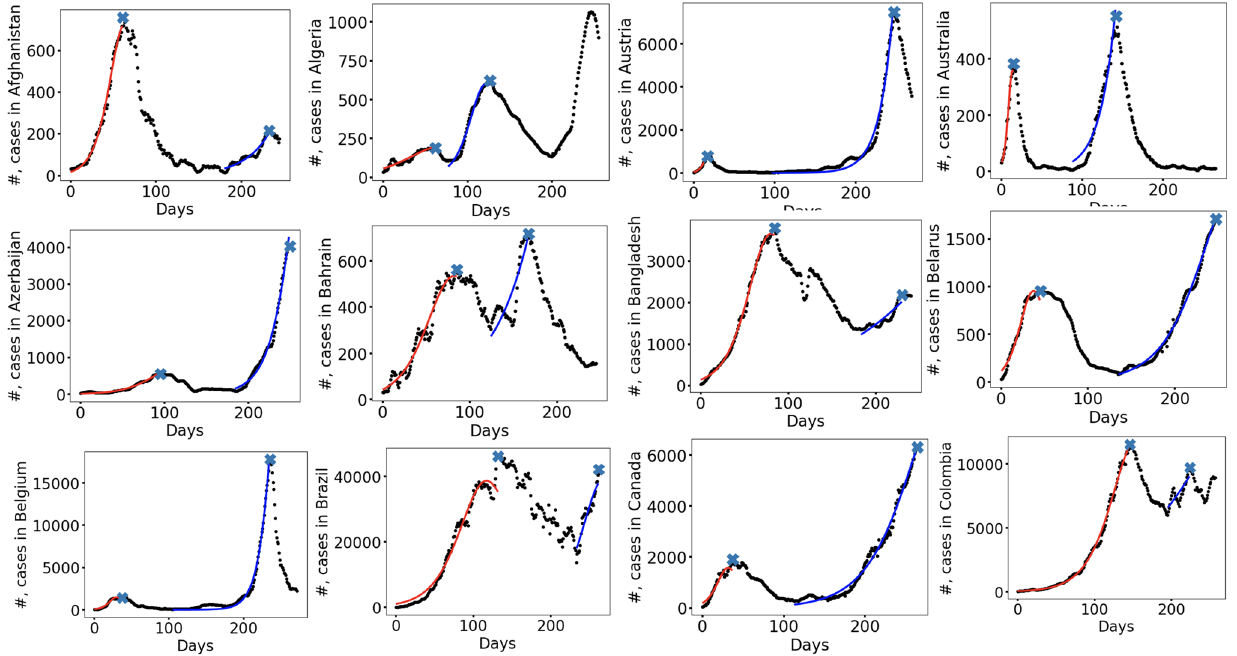
Figure 1. The time course dynamics of COVID-19. The red line corresponds to the first COVID-19 wave, the blue line to the second COVID-19 wave, the blue cross to the peak, and the dotted line to real data.